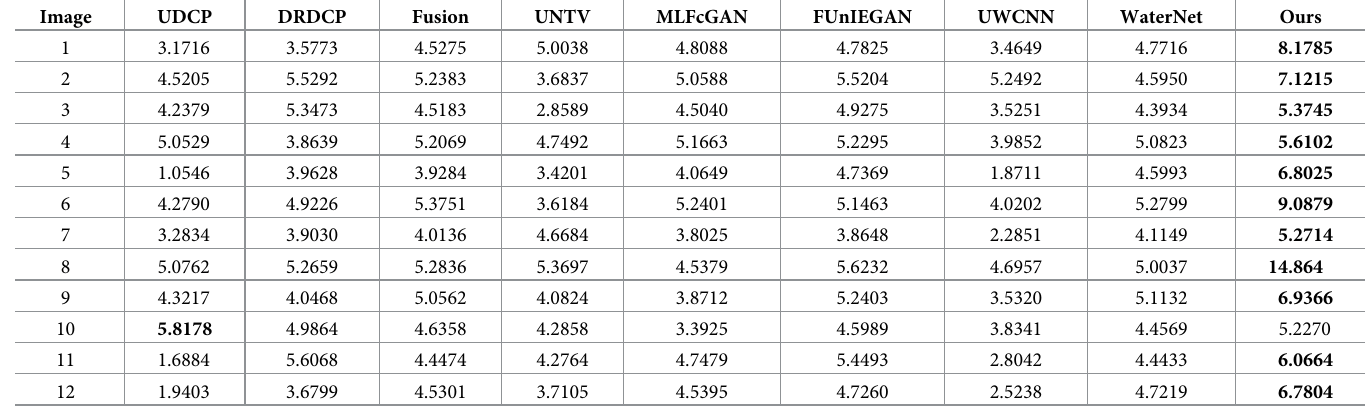
Table 2. Quantitative evaluation results of UIQM